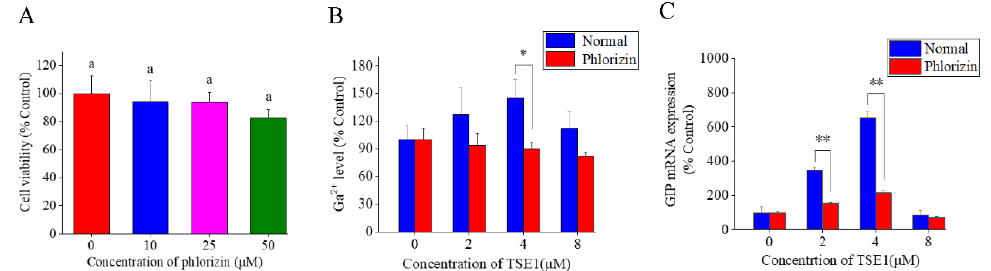
Figure 3. Effect of phlorizin on the Ca 2+ concentration and GIP expression in STC-1 cells at 24 h. ( A ) Cell viability after 24 h treatment of phlorizin determined by MTT assay. ( B ) The intracellular Ca 2+ concentration determined by BBcellProbe F03 assay. ( C ) The mRNA expression of GIP determined by RT-PCR. Different letters indicate significant difference among groups ( p < 0.05). * p < 0.05, ** p < 0.01, compared with normal group.